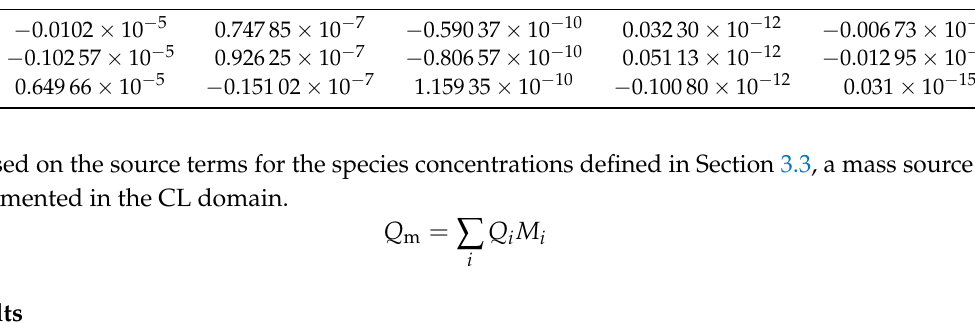
Table 3. Coefficients for the approximation of the dynamic viscosity of the ideal gasses [34]. C 1 C 2 C 3 C 4 C 5 N 2 − 0.0102 × 10 −